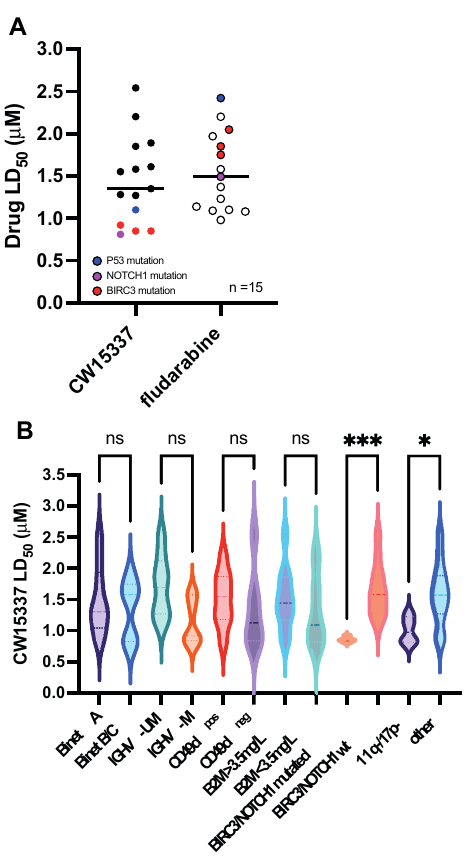
Figure 2. CW15337 is preferentially cytotoxic in CLL cells that carry a BIRC3 or NOTCH1 mutation. ( A ) All of the CLL samples tested had low micromolar LD 50 values, with a mean of 1.44 µ M for the entire cohort. ( B ) Comparative analysis of the sensitivity to CW15337 in CLL prognostic subsets revealed that samples derived from patients carrying a BIRC3 or NOTCH1 mutation were particu- larly sensitive to CW15337; the same samples showed increased in vitro resistance to fludarabine. *** p < 0.001, and * p < 0.05. ns = not significant.